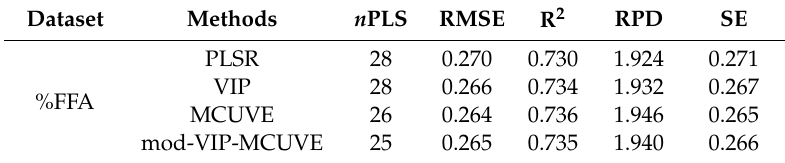
Table 4. The RMSE, R 2 , RPD, and SE in variable selection methods using %FFA data.